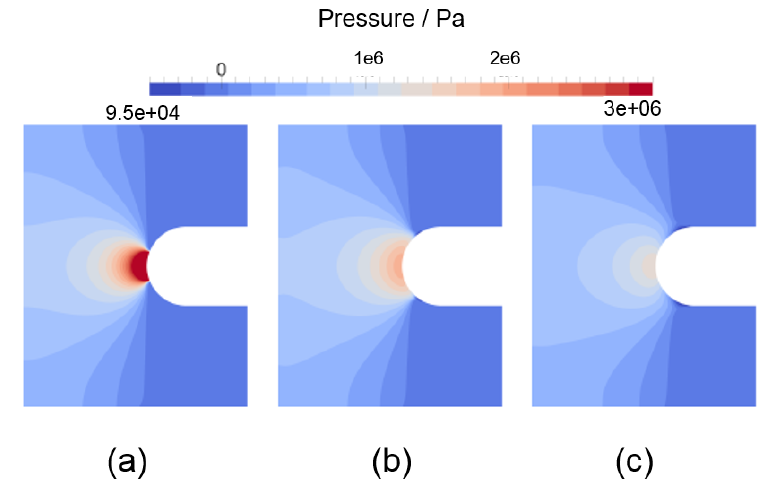
Figure 6. The pressure field at the times of impact and immediately afterwards: ( a ) t · U = 0.205; ( c ) t · U = 0.21. Here, U = U in with U in = 20 ms − 1 R